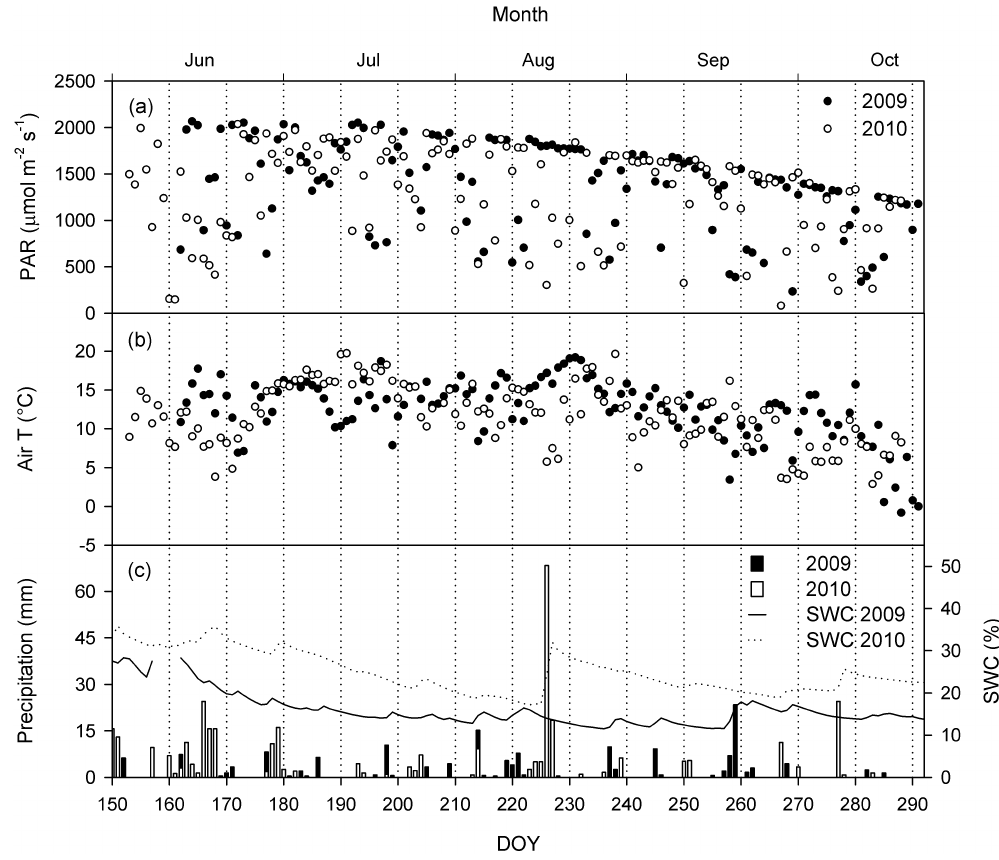
Fig. 2. Seasonal variation of 2009 (solid line, black bars) and 2010 (dotted line, white bars): (a) midday average air temperature (Air T , ◦ C); (b) PAR (µmolm − 2 s − 1 ); (c) precipitation (mm) and soil water content (SWC, %) at